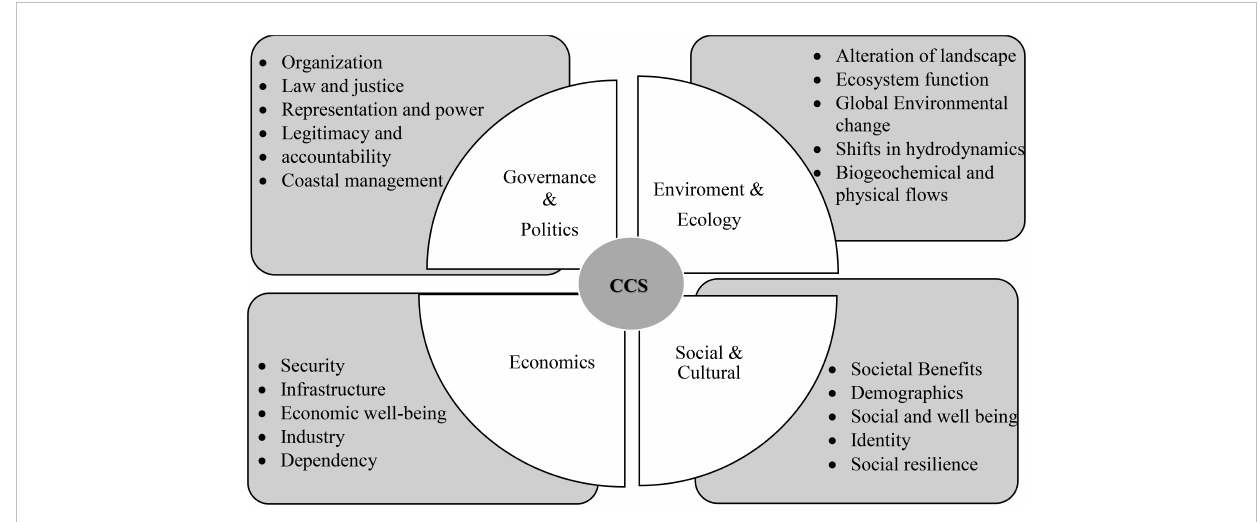
FIGURE 4 Combination of sectoral categories for coastal sustainability